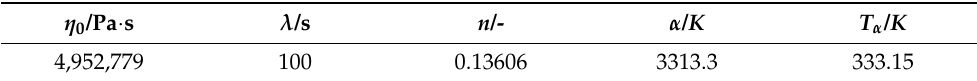
Table 2. Parameters of the Bird–Carreau viscosity curve at 60 ◦ C and the parameters from Arrhenius law to describe temperature dependence.